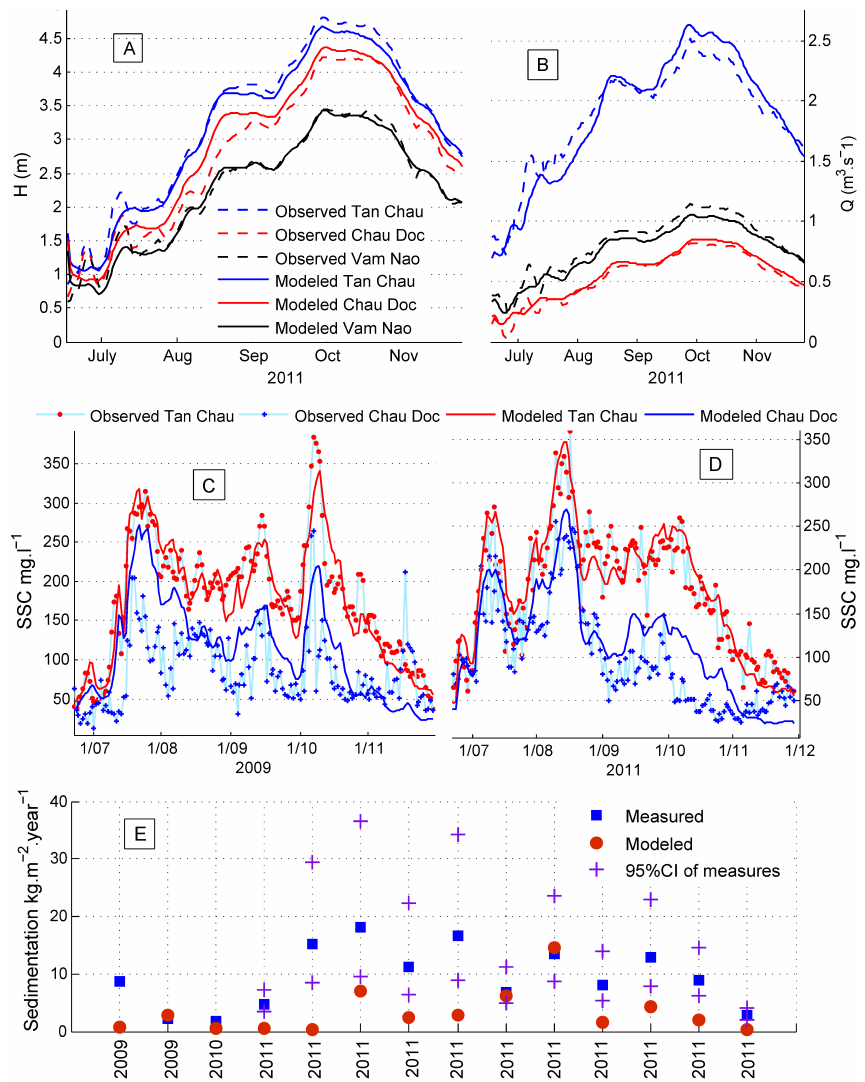
Figure 5. Model performance: top panel: comparison of measurements and simulation results at stations Tan Chau, Chau Doc and Vam Nao for 2011: (a) daily water levels, (b) daily discharges. Middle panel: comparison of measurements and simulation results at Tan Chau and Chau Doc: (d) daily SSC for the calibration year 2011, and (c) for the validation year 2009. Bottom panel: (e) comparison of measured and simulated sedimentation (2 locations in 2009, 1 location in 2010, 11 locations in